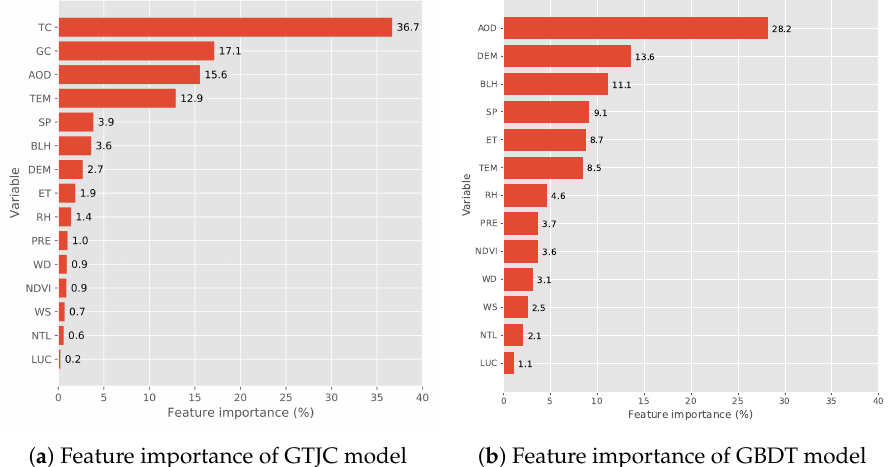
Figure 4. Permutation feature importances of ( a ) geospatial-temporal joint codes model (GTJC) model and ( b ) gradient boosting decision tree (GBDT) model. The calculated feature importance values are normalized to percentages and sorted in descending order of